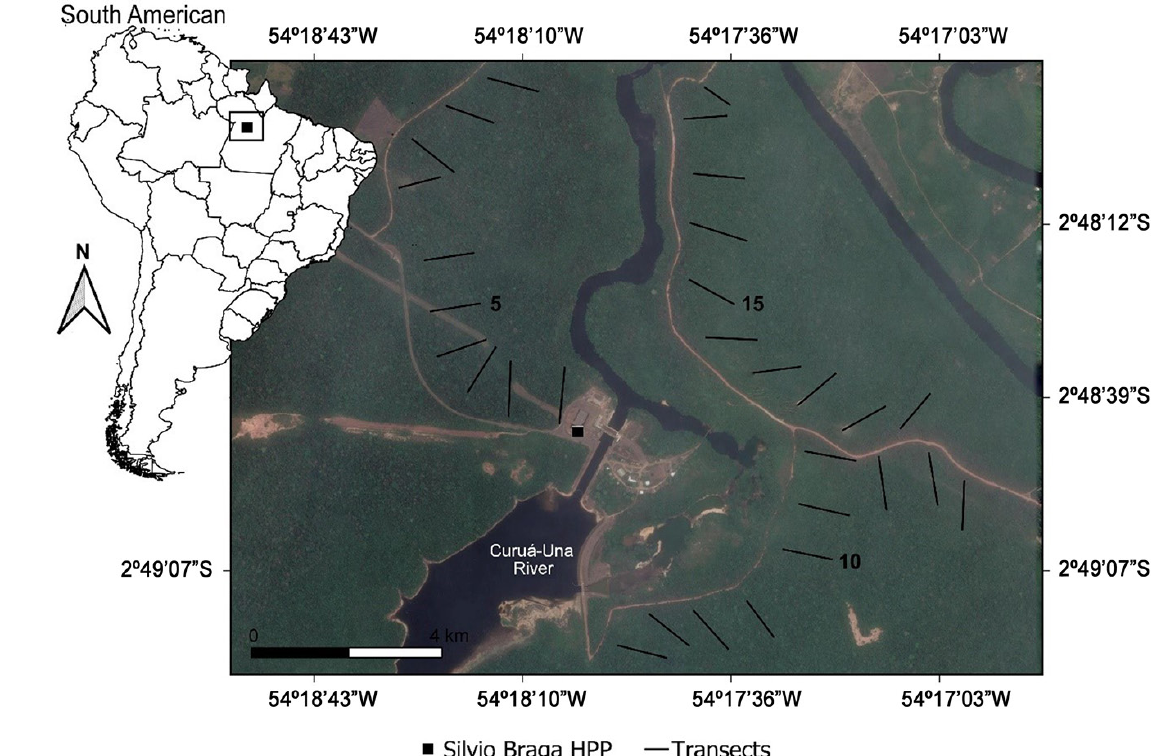
Figure 1. Study area with indication of transects (black lines) for Hymenochaetales and Polyporales collection. The numbers indicate the position of artisanal rain gauges in the study